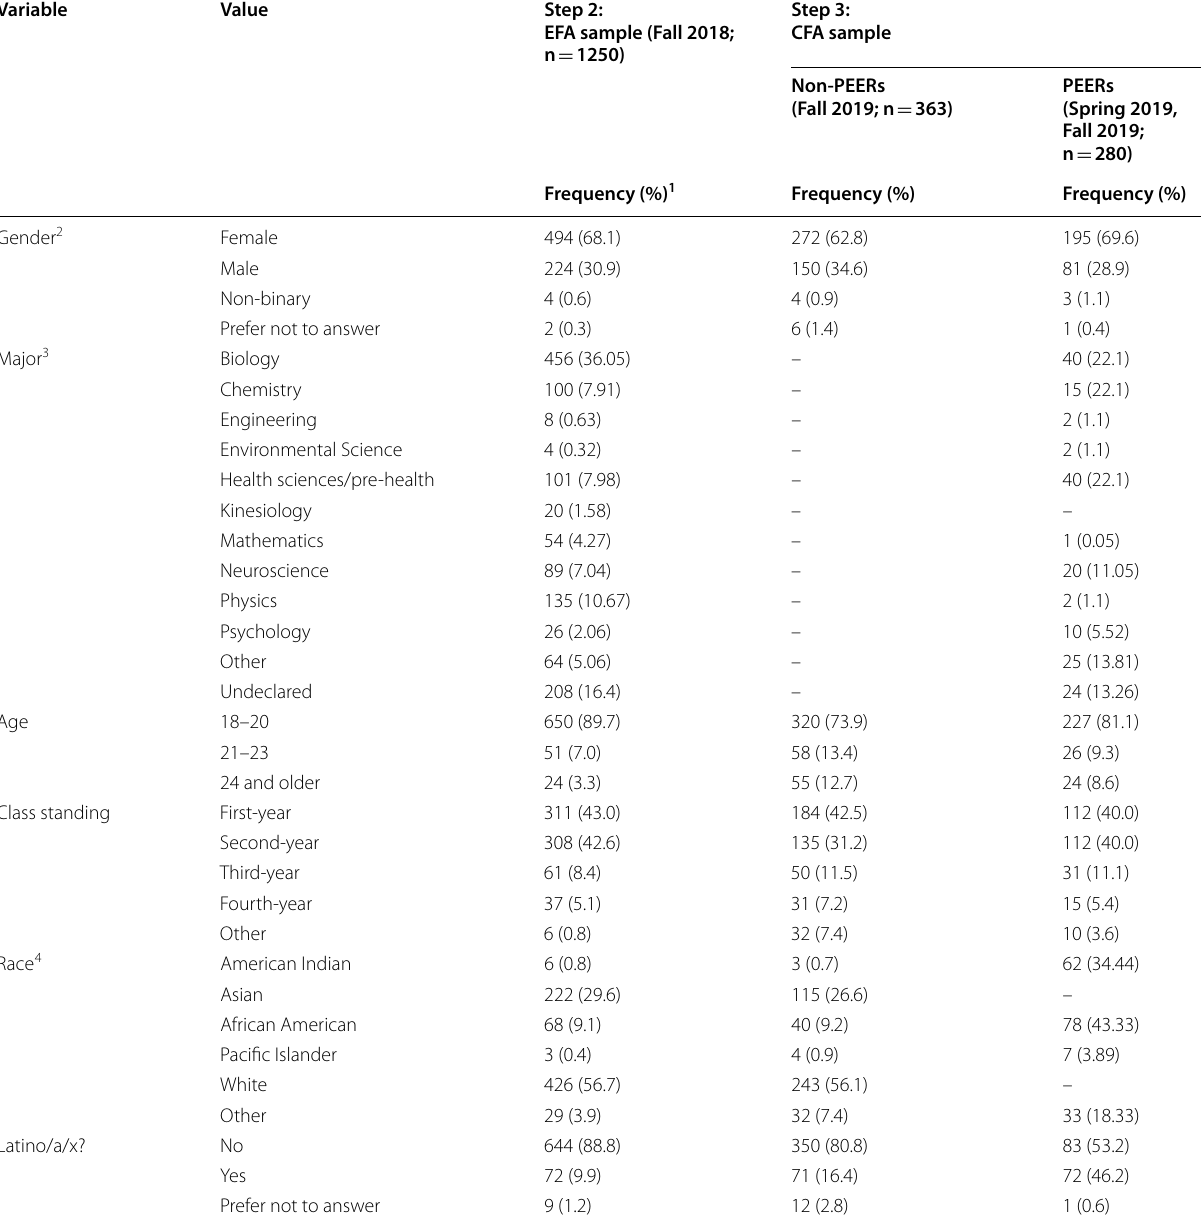
Table 1 Demographic characteristics of